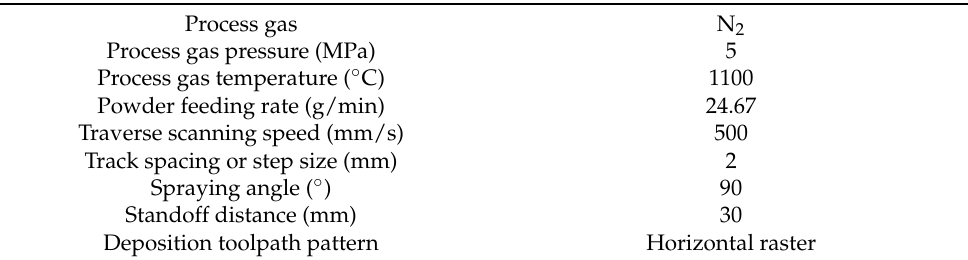
Table 2. Key process parameters used to deposit Ti6Al4V cold spray (CS) coatings on Ti6Al4V